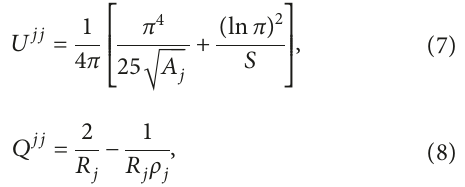
(Figure 3). Their shapes are as follows: ① cross board (side length � 0.5 m and thickness � 0.02 m); ② sphere (diame- ter � 0.2656 m); and ③ square plate (length � width � 0.5 m and thickness � 0.02 m). There are 6,722 discrete points on the surface of the cross board, 6316 discrete points on the surface of the sphere, and 6000 discrete points on the surface of the square plate. The distributions of the discrete points of the three markers on the dam face are shown in Figure 4. The scattering effects of the three markers on the sound waves of different frequencies and different incident angles were compared. The frequencies of the sound waves are 7, 10, and 14kHz, respectively. The incident angles, i.e., the included angles with XZ plane, are 0 ° and 15 ° , as shown in Figure 1. In order to quantify the numerical simulation results, the sound pressure level (SPL) was used as the indicator to determine the scattering effect. The equation for SPL is as follows [33]: